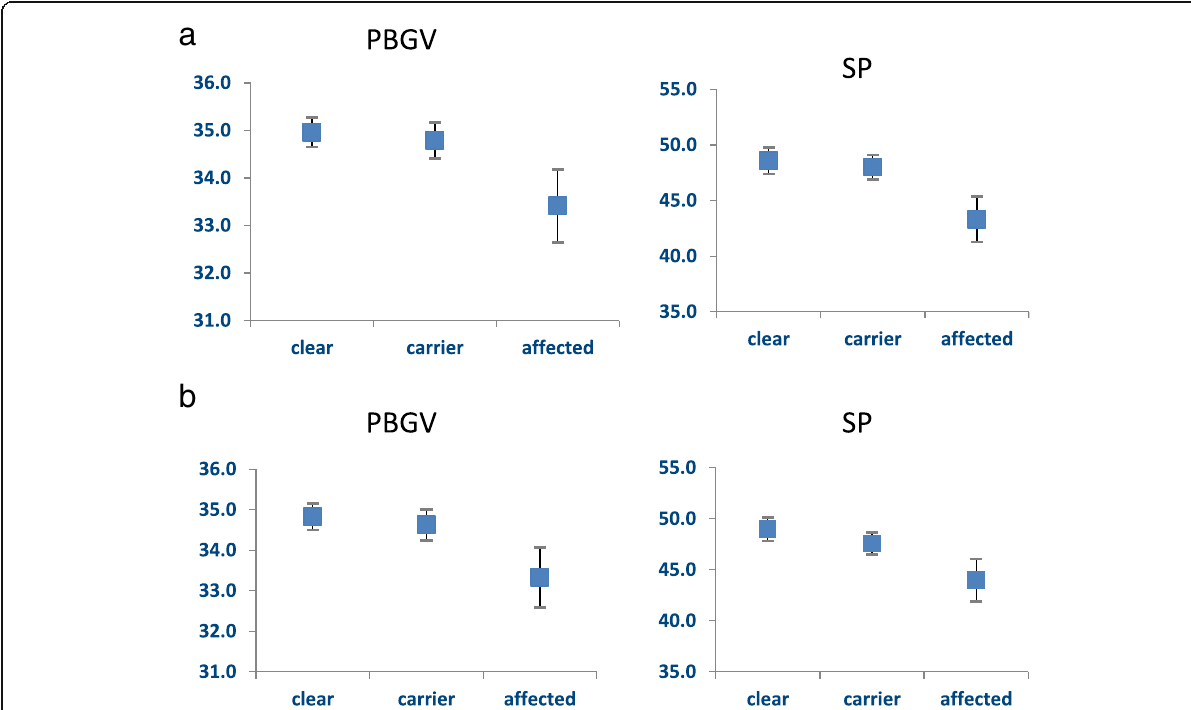
Fig. 1 Association between height and ADAMTS17 genotype. a . Unadjusted mean heights and 95% confidence intervals for each genotypic category. b . Age and sex-adjusted mean heights and 95% confidence intervals for each genotypic category